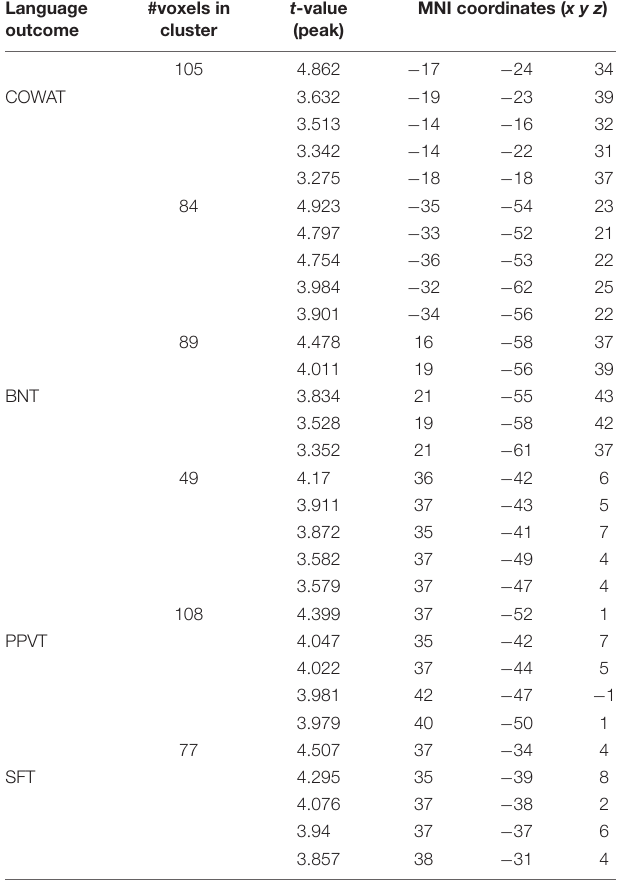
TABLE 2 | Locations of regions showing significant relationships between FA and behavioral scores indicated in Figure 2A . Language